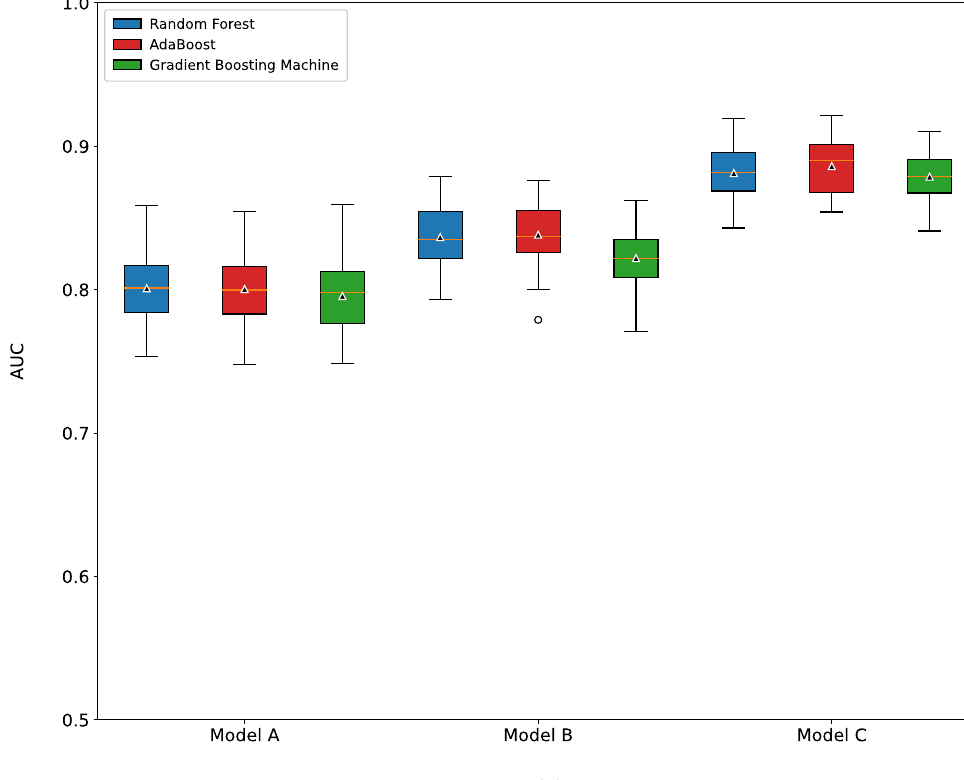
Figure 3. The box plot for AUROC score of three different prediction models among three different data types. Model A — trained model based on checkup features. Model B — trained model based on data types. Model A—trained model based on checkup features. Model B—trained model based on survey features. Model C — trained model based on total (survey + checkup) features. survey features. Model C—trained model based on total (survey + checkup)